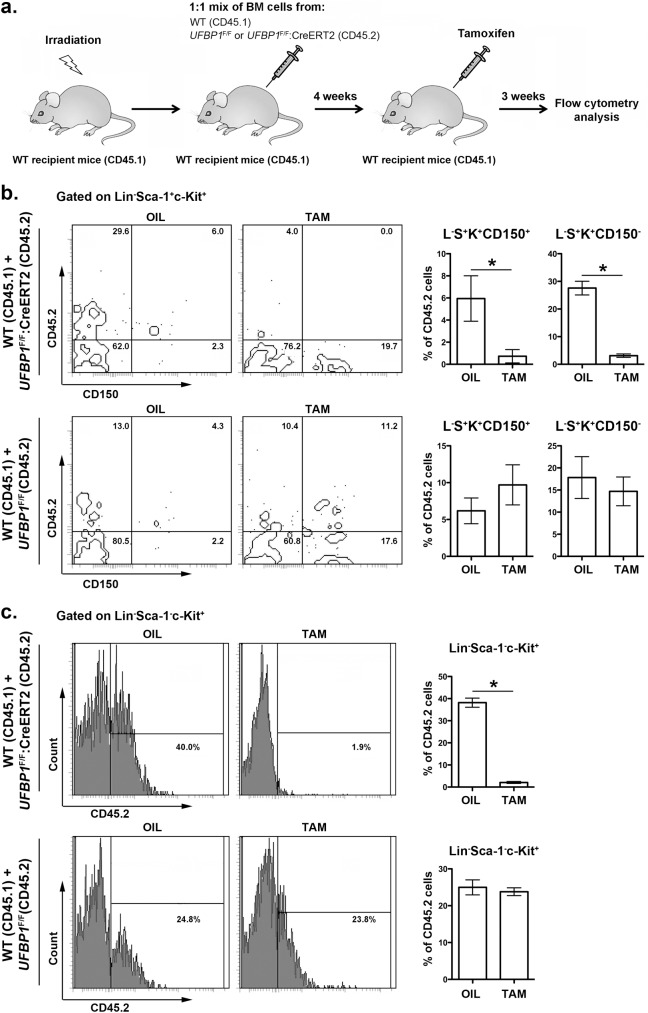
UFBP1 is essential for HSC function.
a. Experimental scheme for competitive repopulation assay. b. Contribution of UFBP1 deficient cells (CD45.2) to long-term HSCs (L-S+K+CD150+) and multipotent progenitors (L-S+K+CD150-). * p < 0.001 (n = 5). c. Contribution of UFBP1 deficient cells (CD45.2) to oligopotent progenitor cells (L-S-K+). * p < 0.001 (n = 5). Data are presented as means ± SD. The unfractionated BM cells from either UFBP1
F/F or UFBP1
F/F:CreERT2 (CD45.2) were mixed with wild-type (CD45.1) BM cells at a 1:1 ratio, and co-transplanted into lethally irradiated recipient CD45.1 mice. Four weeks after transplantation, the mice were treated with either oil or TAM. Three weeks after initiation of the treatment, the BM cells were isolated and subjected to flow analysis using indicated markers.